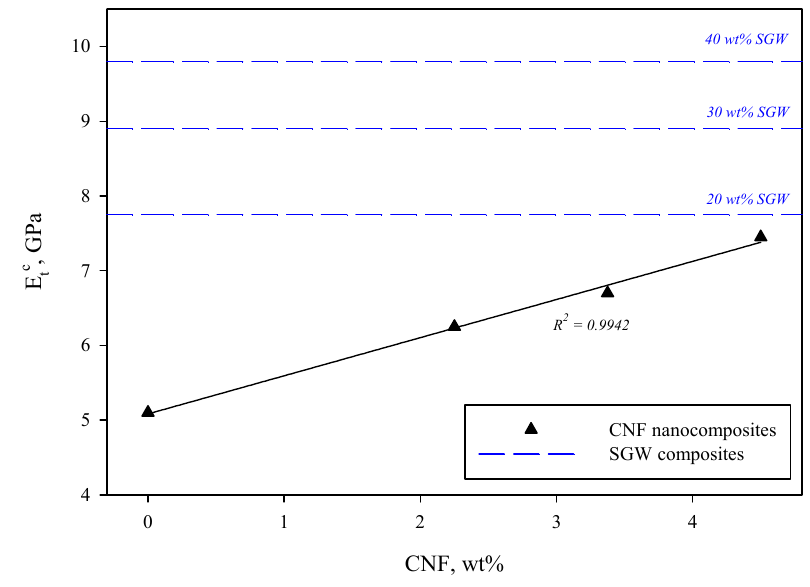
Figure 4. Evolution of Young’s modulus (E tc ) as the amount of CNF was increased. Blue dashed lines indicate the Young’s modulus of PVA/SGW composites at different SGW content for comparison purposes.